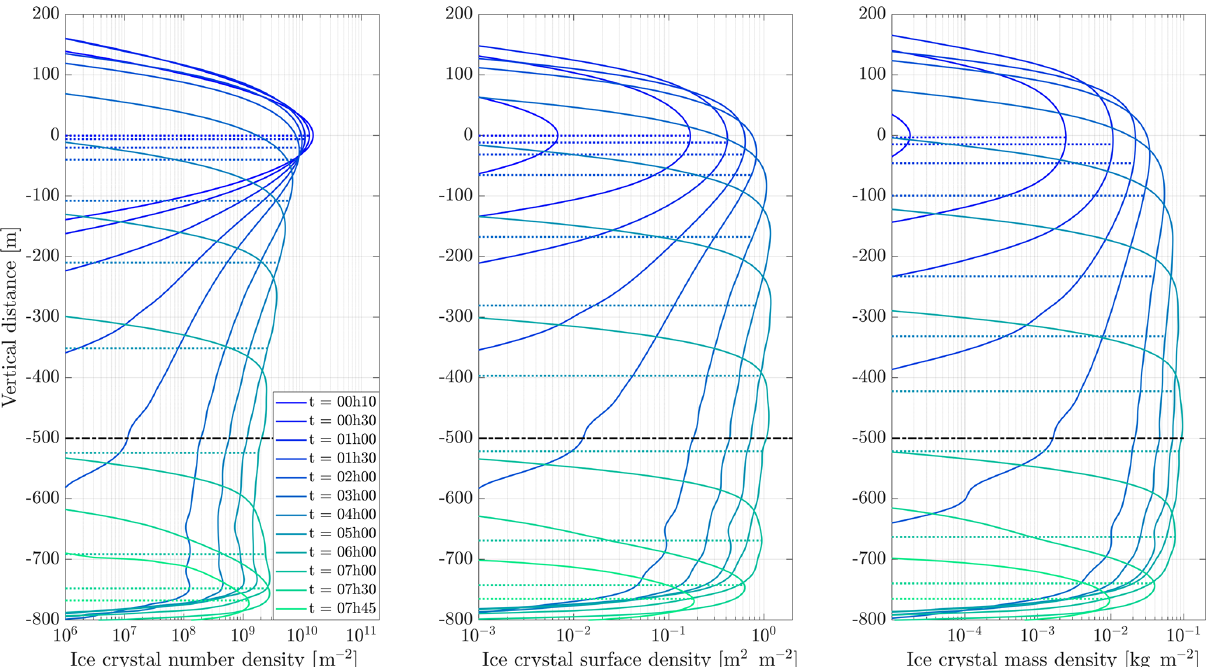
Figure D3. Time evolution of horizontally integrated ice crystal number, surface and mass densities. The color gradient refers to the contrail age. The supersaturation region extends from ± 500m around the flight altitude (represented as a dash-dotted black line). The median of each distribution is plotted as a dotted